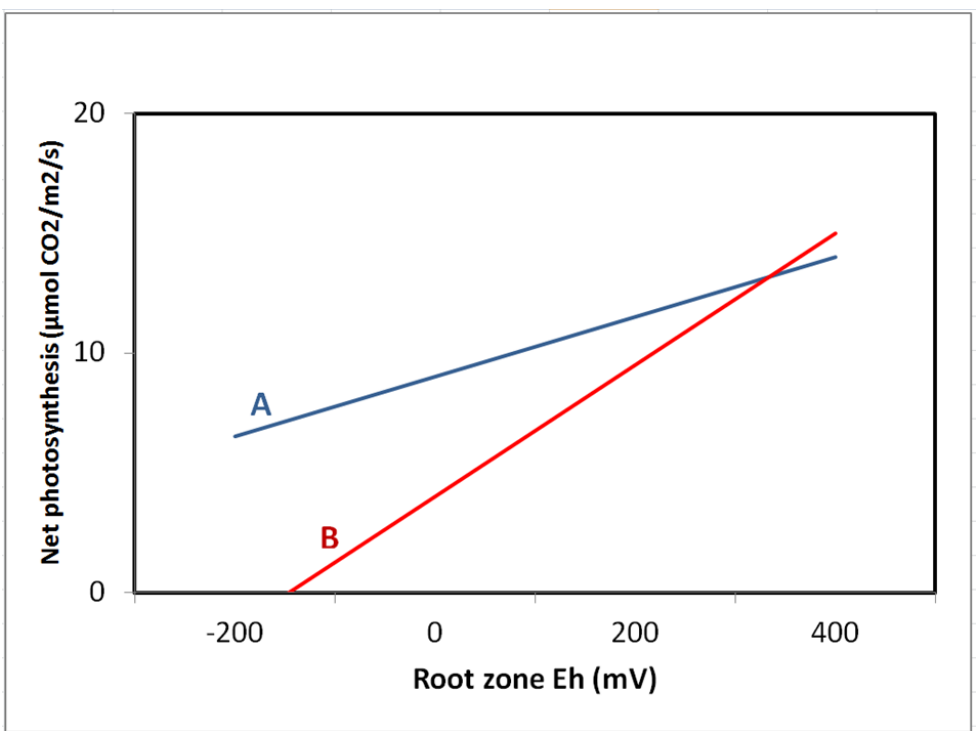
Figure 5. Response of light saturated leaf photosynthesis to root-zone redox potential (Eh) for 5-year-old (A) Fraxinus pennsylvanica and (B) Quercus bicolor in a created wetland (from Pennington and Walters